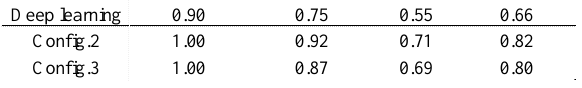
Table 2. Performance with Deep learning